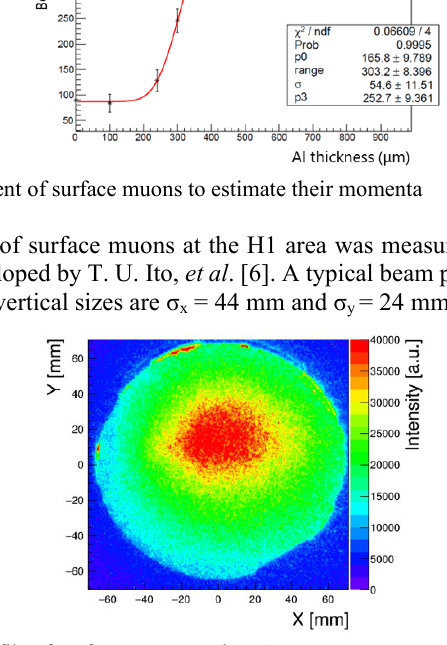
Fig. 4. Typical beam profile of surface muons at the H1